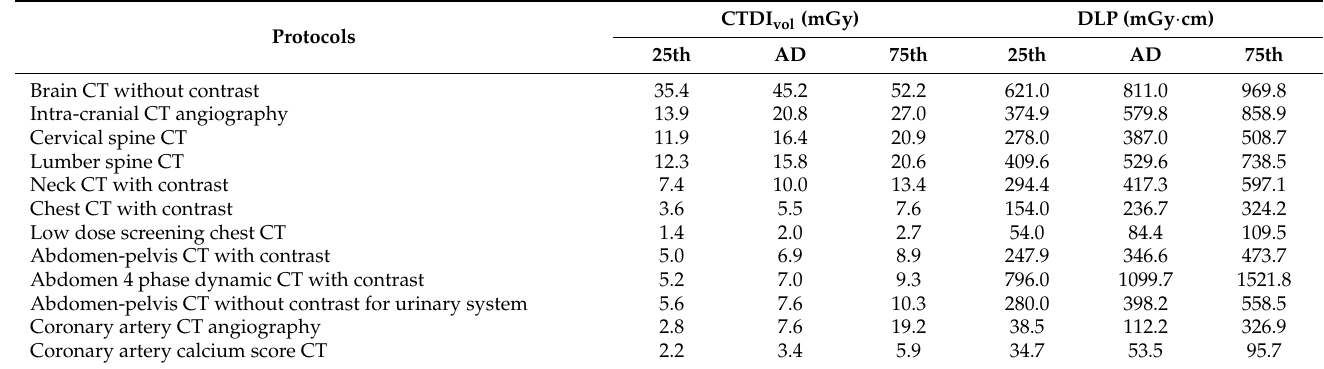
Table 3. 25th and 75th percentile DRLs and Ads of CTDI vol and DLP values for adult CT examinations.